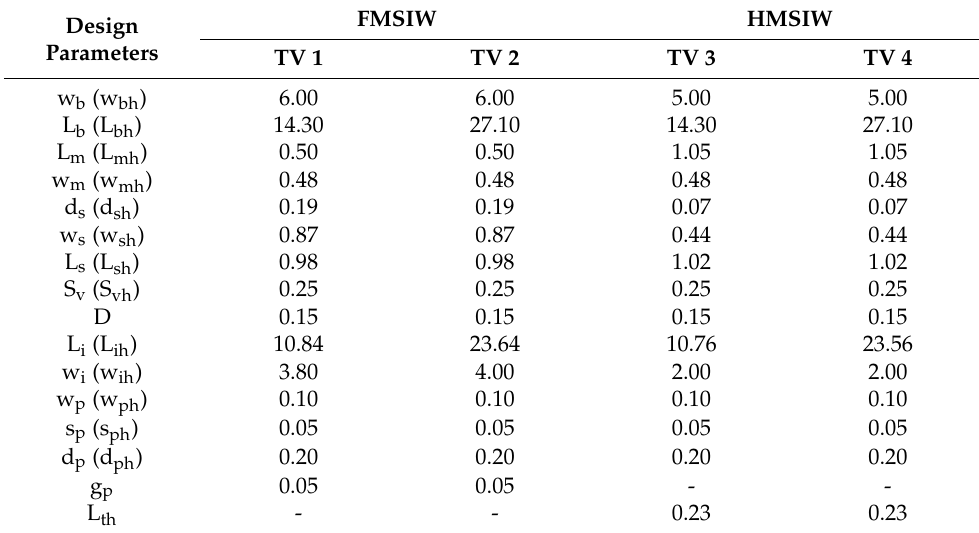
Table 1. Design parameters and dimensions of TVs for FMSIW and HMSIW (units: mm).